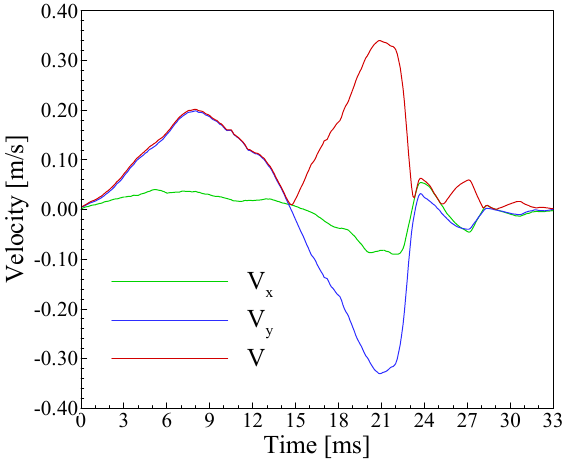
Figure 11. Time histories of the termite head velocity in a 33-ms head-banging period.